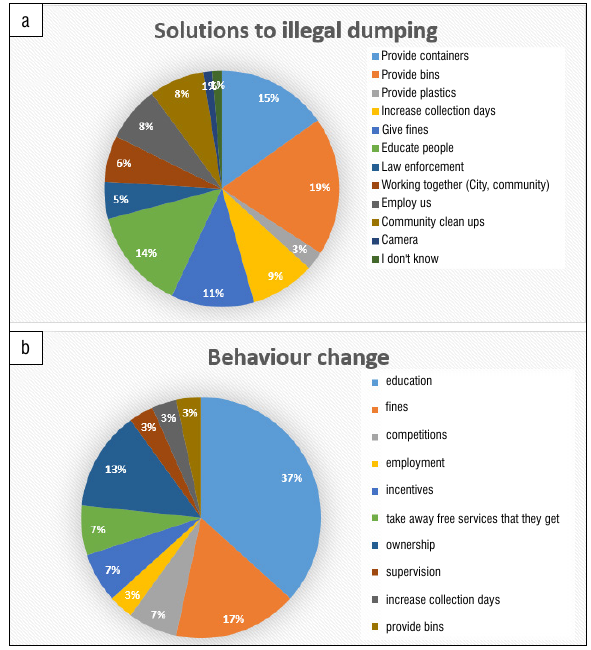
Comparative responses in regard to (a) solutions to illegal dumping and (b) strategies for behavioural